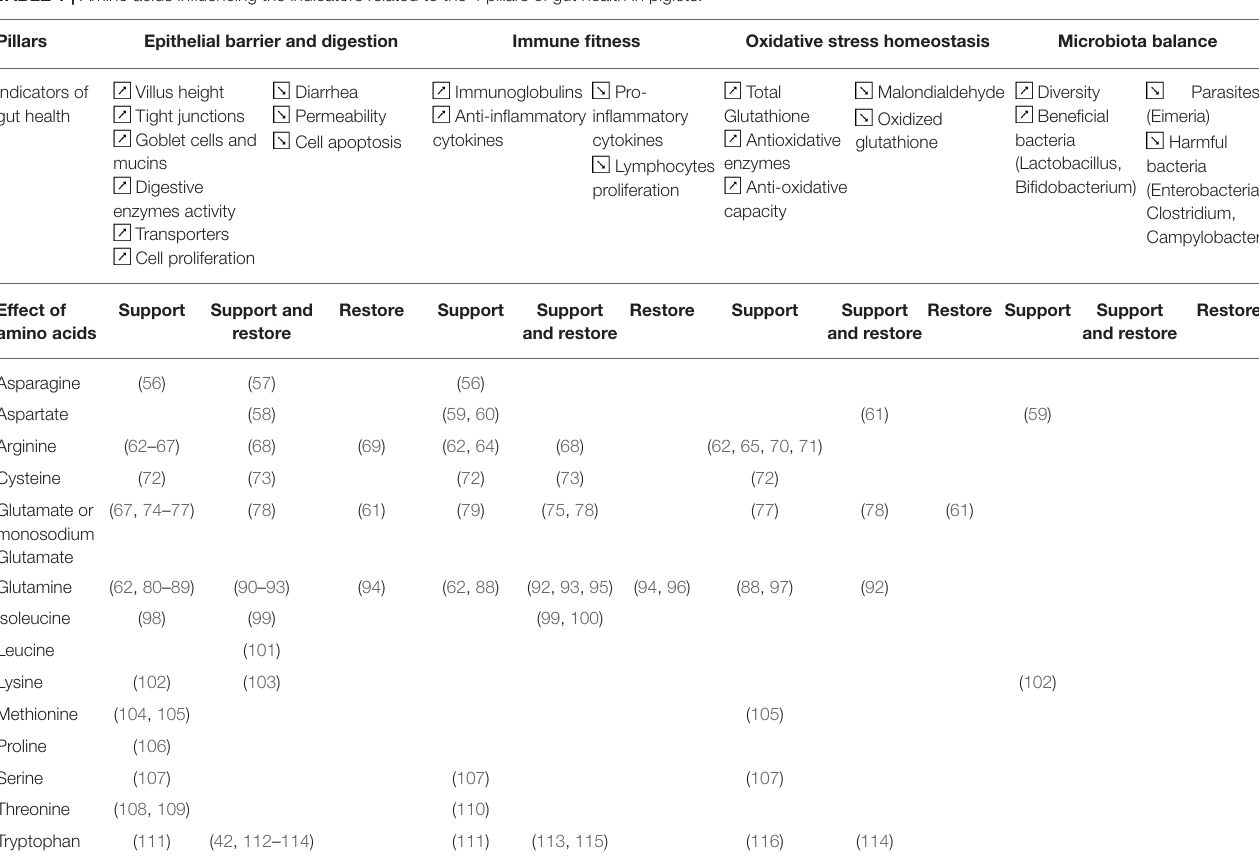
TABLE 1 | Amino acids influencing the indicators related to the 4 pillars of gut health in piglets. Pillars Epithelial barrier and